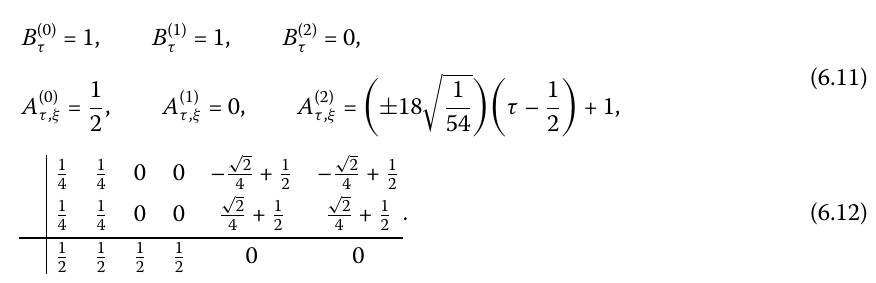
and method (5.7) as γ (0)